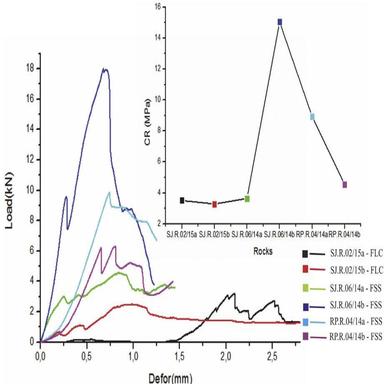
Compressive resistance (CR) test behaviour for lateritic crust (sample SJ.R.02/15) and ferruginous sandstones (sample SJ.R.06/14) from the FSJM and outcrops at the Pedreira River (RP.R.04/14), which in this case are identified as possible sources of raw material.